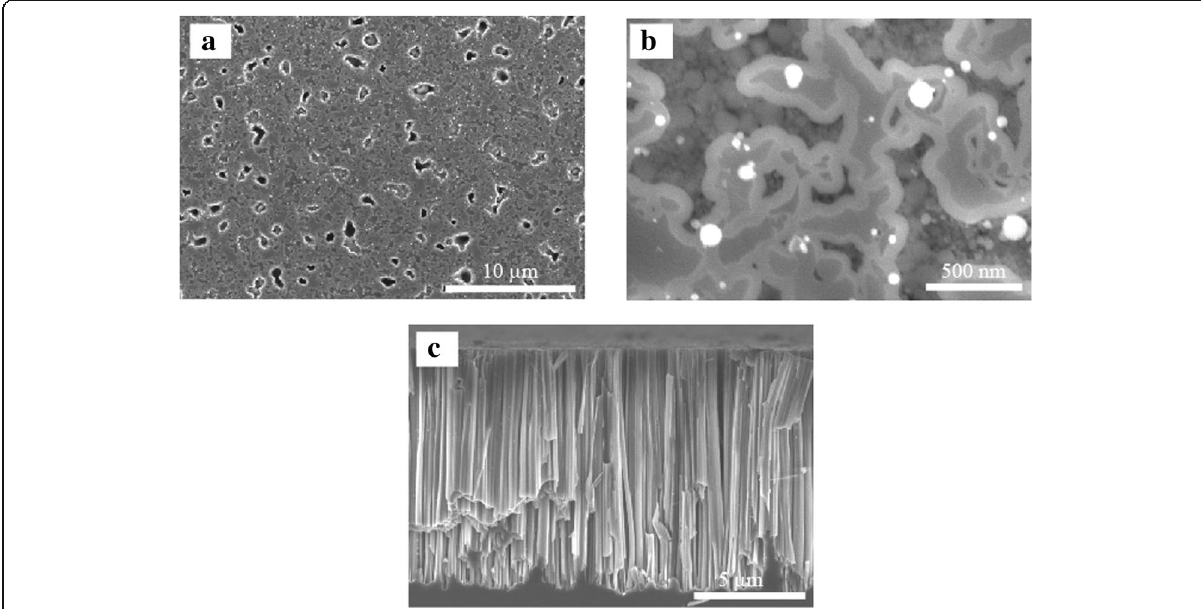
Fig. 6 a Low-magnification top view of the SEM image of SiNWs with Al 2 O 3 after CMP. b High-magnification top view of the SEM image of SiNWs with Al